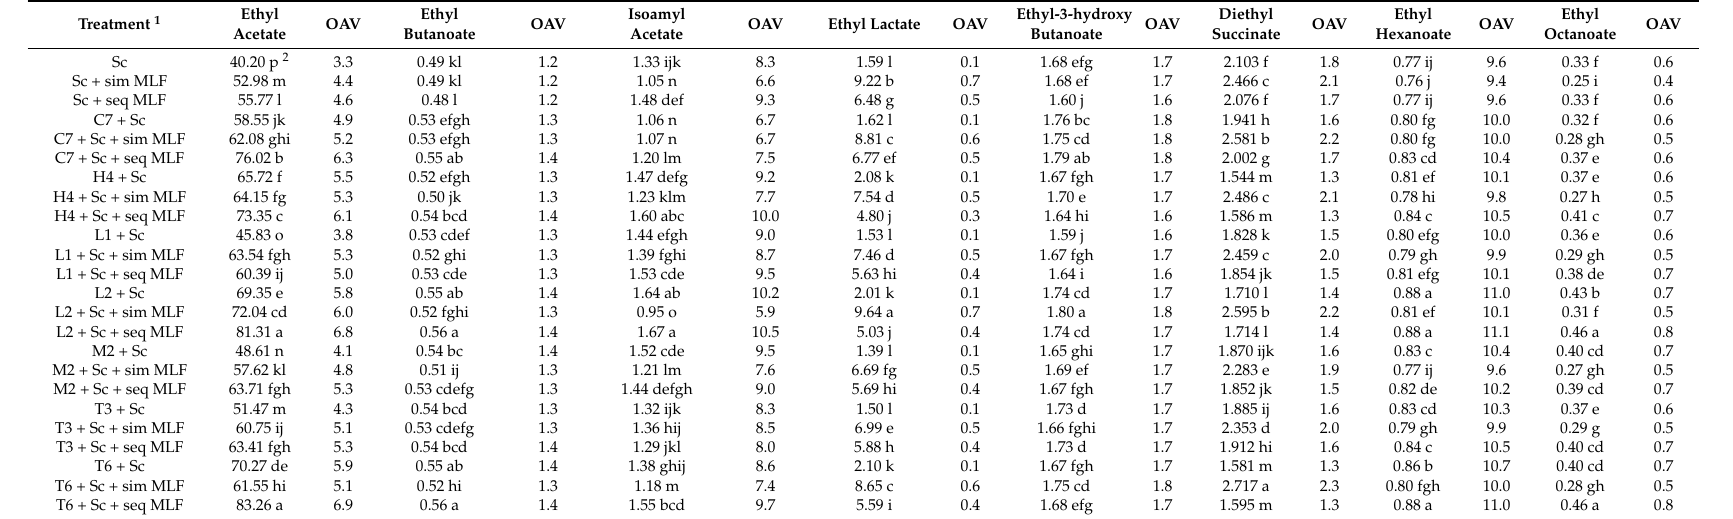
Table 3. Concentrations of volatile compounds (mg/L) and their calculated odor activity values (OAV) of bottled Shiraz wines produced with different yeast 1 strains in combination with three malolactic fermentation (MLF) strategies (none, simultaneous and sequential). Values are averages of three replicates. Treatment